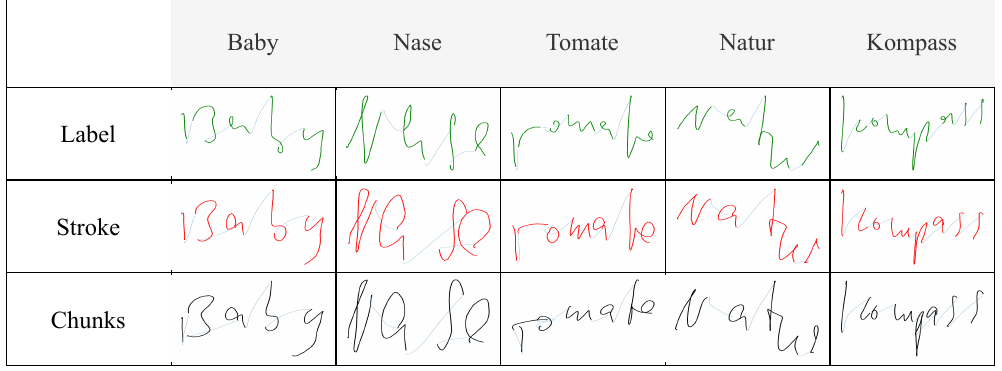
Figure 7. Trajectory recovery results when writing on